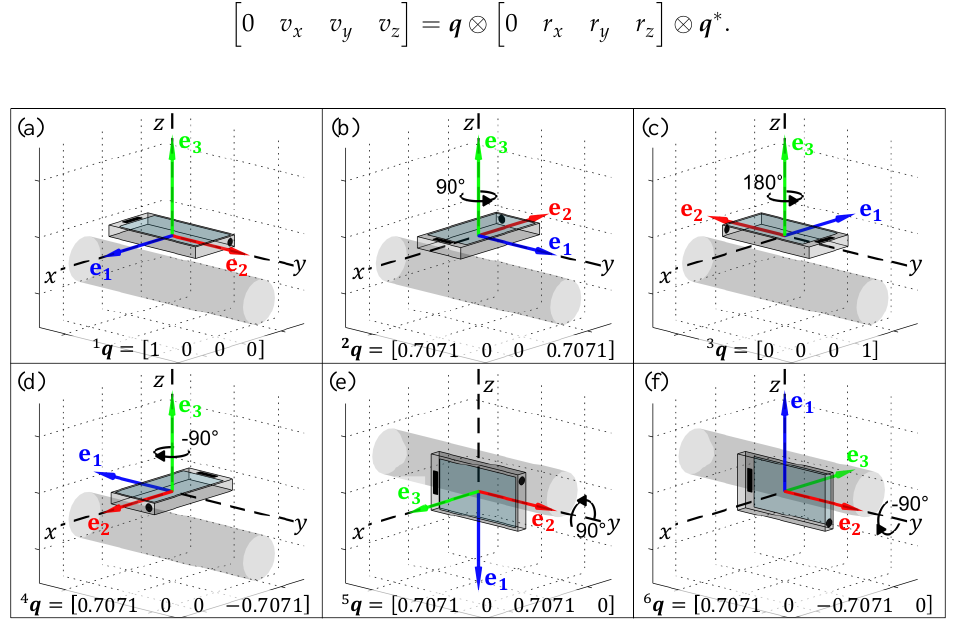
Figure 1. Six common ways that the inertial measurement units (IMU) might be placed in the pants pocket (assuming a seated position). The cylinder in each panel represents the orientation of the participant’s right thigh whilst seated (with the knee to the right-hand side of each image). The dashed lines labeled x , y , and z denote the original device reference frame, 1 q , whilst the orthogonal basis defined by the vectors, e , e , and e illustrate the device orientation generated. In panels ( a – d ) the 2 3 1 IMU is located on the anterior surface of the thigh (i.e., a pocket on the front of the pants), whilst in panels ( e , f ) the IMU is located on the lateral surface of the thigh (i.e., a pocket on the outer side of the pants).